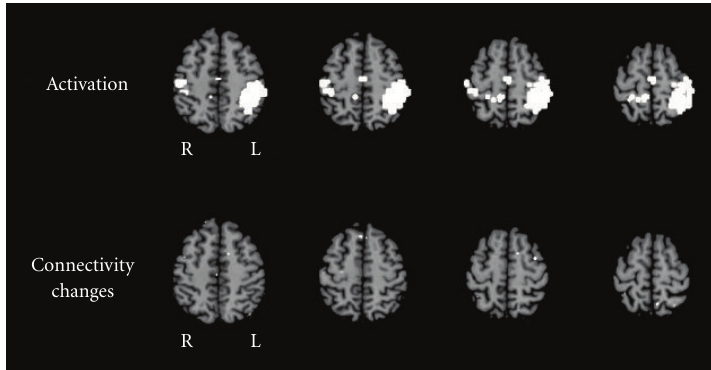
Figure 1: Group activation and connectivity changes maps for six subjects in a rest-fingertap block design paradigm. The connectivity changes map shows the voxels with significant changes in the information flow intensity from SMA, between rest and fingertap condition. The maps are presented on radiological